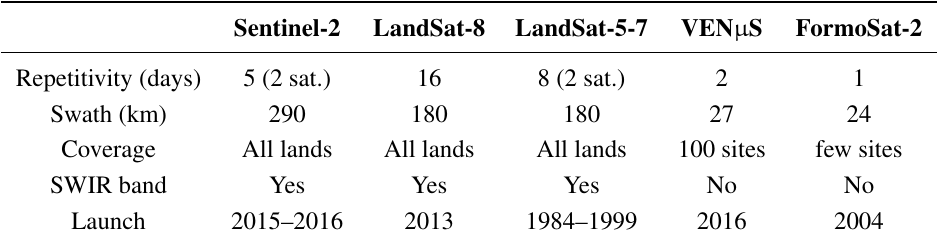
Table 1. Satellite